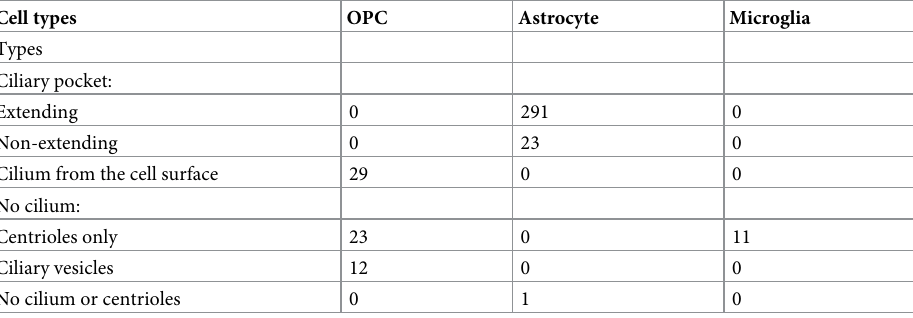
Table 2. Types of centrioles and